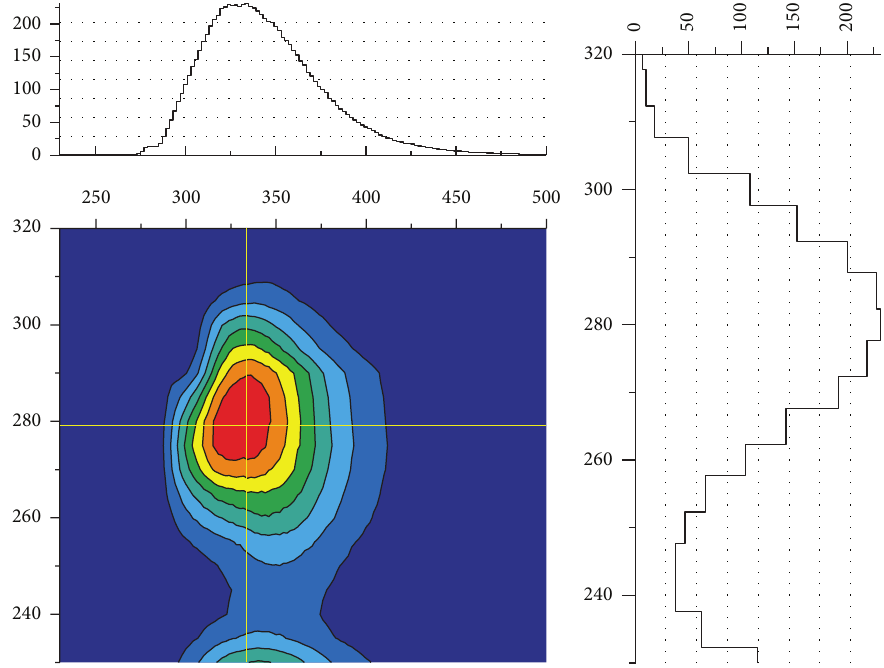
Figure 4: The contours of the excitation-emission matrix (EEM) spectrum of pure catechol